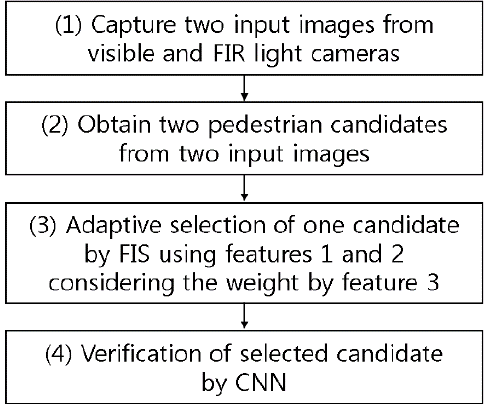
Figure 1. Overall procedure of the proposed system.